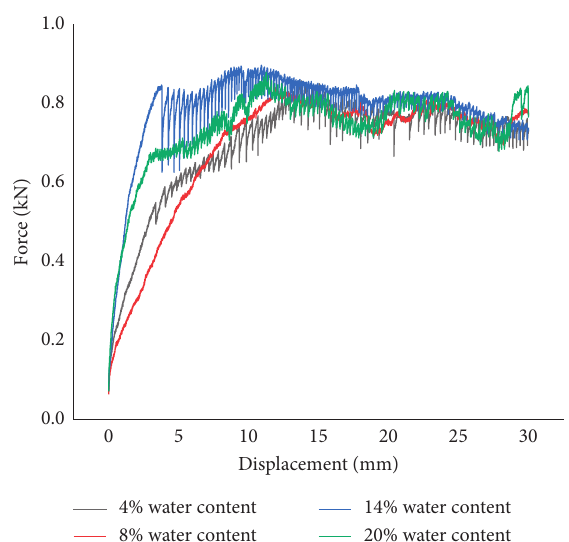
Figure 9: The pullout force-displacement curve with different water content for 30 dry-wet cycles under overburden pressure of 5kPa.